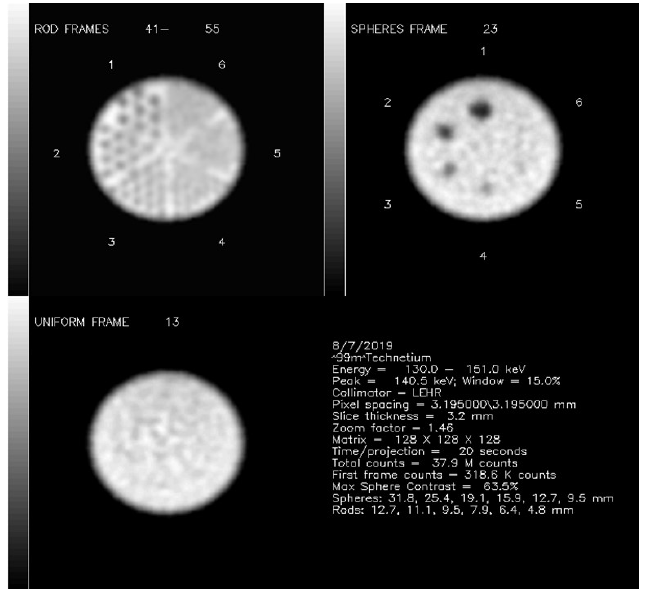
Figure 1. Example of composite image. In this case, both readers agreed there were no perceptible artifacts in any phantom